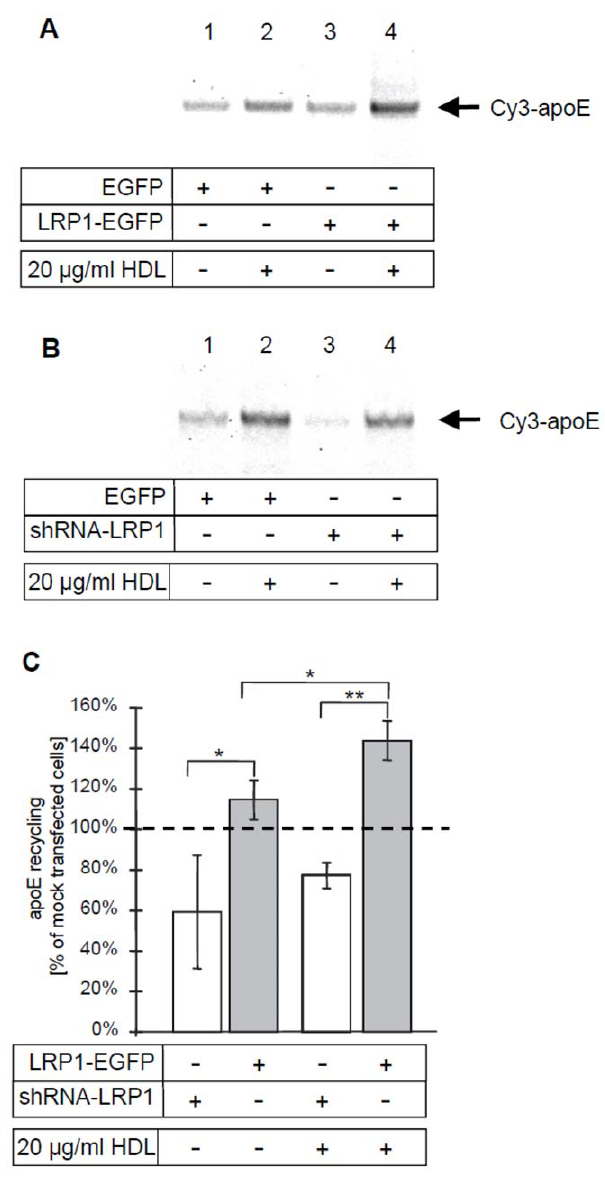
Figure 7. LRP1-dependent apoE recycling. HEK293 cells were transfected with pFB-LRP-EGFP, an shRNA vector against LRP1 or EGFP as control [31]. Pulse-chase experiments were performed by incubating HEK293 cells with Cy3-apoE-TRL for 60 min at 37 u C. Cells were washed with heparin and incubated for additional 60 min at 37 u C with media in the presence or absence of 20 m g/ml HDL 3 . Then cell culture media were harvested and the amount of re-secreted Cy3-apoE was determined by SDS-PAGE and subsequent in-gel fluorescence detec- tion. The position of apoE is indicated. Representative gels with the corresponding apoE bands are shown for LRP1-EGFP overexpression (A) and reduced LRP1 expression (B). The highest and lowest intensity in each gel is represented as maximum black and white, respectively; therefore only intra-gel comparisons were performed. The quantifica- tion of these experiments is shown as percent recycling versus the corresponding mock transfected cells, which was set to 100% in order to ensure a valid comparison of the changes in apoE recycling between the different experiments (C). *: p , 0.05, **: p , 0.01 for Student’s t-test (n $ 4) 6